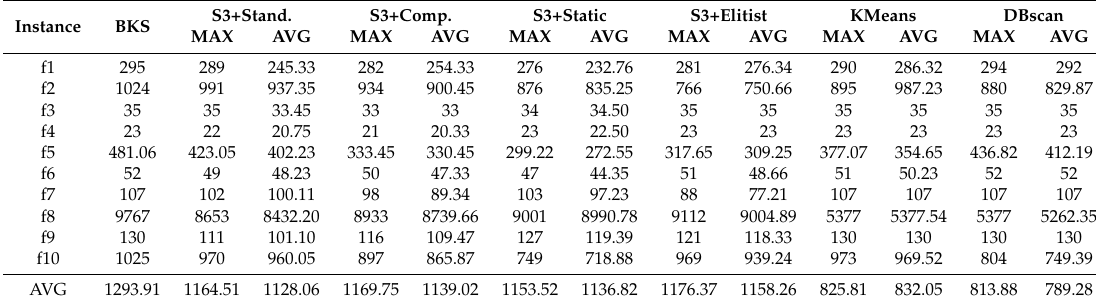
Table A14. CSA/KP—SShape 3—Two-steps vs. KMeans vs. DBscan.